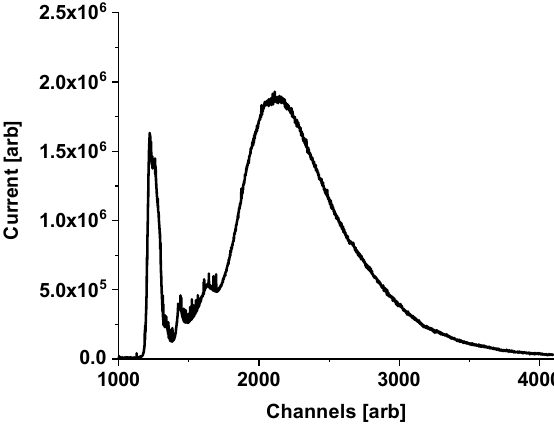
Fig. 8. FC pulses summed for 160000 reactor bursts. 2*10 6 pulse/cm 2 in the FC. According to the plot in Fig. 9 prompt fission gammas plus neutrons escaped the moderator produce by factor 31.08 pulses less. For the thermal neutron region the neutron capture cross section about250 times higher, meaning that the neutrons would produce by factor 250 more pulses than gammas and the intensity of pulses from gammas would be at least 31.08 times less. From these rough speculation the sensitivity of FC to gamma radiation would be ~7000 less than sensitivity to thermal